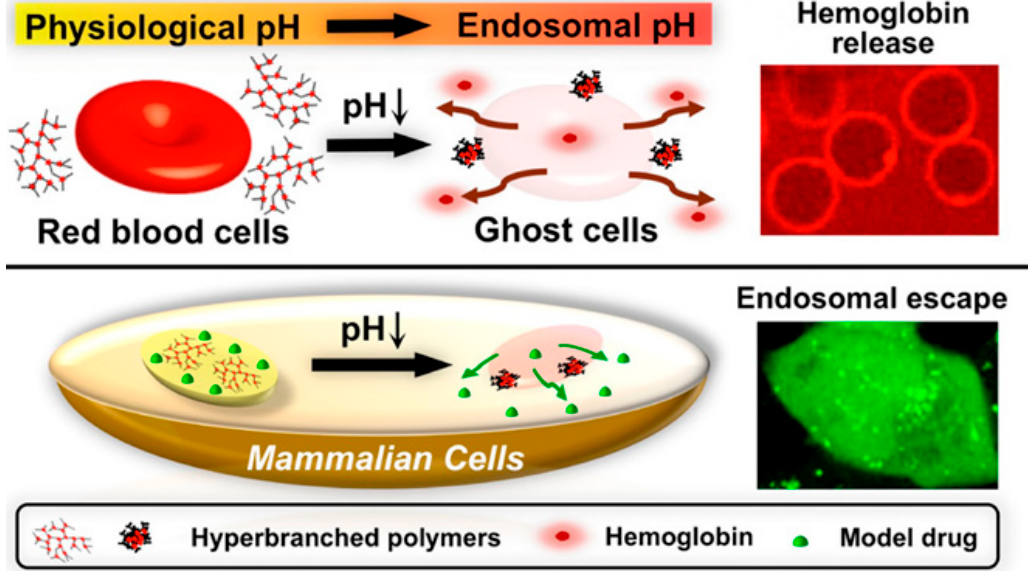
Figure 15. Illustration of the intracellular delivery of biological payloads from lysine-based hyperbranched polymers. Reproduced with permission from [209]. Copyright 2017, American Chemical Society.